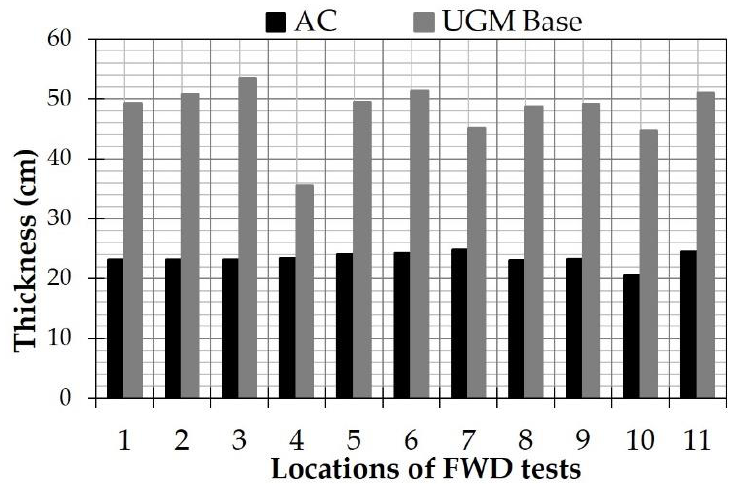
Figure 11. Thicknesses of the Asphalt Concrete (AC) layers and the Unbound Granular Material (UGM) base layer. Table 6. Overview of back-analysis